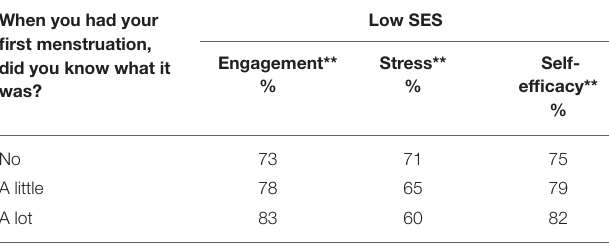
TABLE 11 | Predicted MENSES scores by SES and knowledge level about what their period was when they had it for the first time. When you had your first menstruation, did you know what it